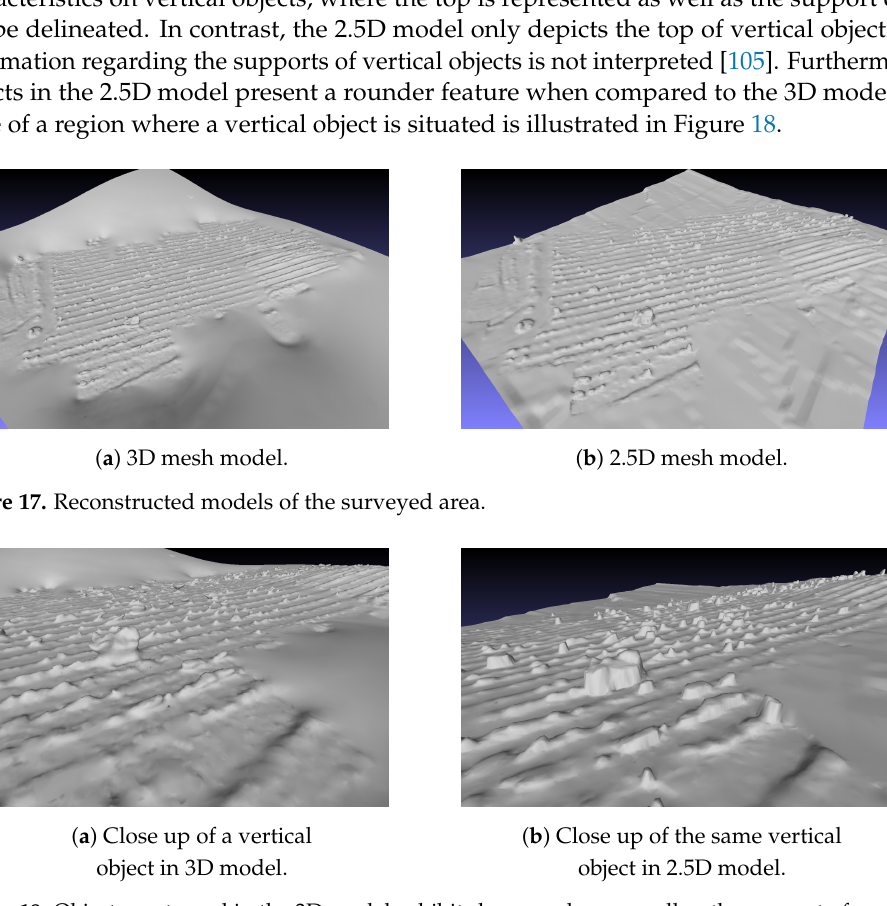
Figure 18. Objects portrayed in the 3D model exhibit sharper edges as well as the support of vertical objects are better delineated. In contrast, 2.5D model edges are rounder and vertical objects overhung areas do not present any